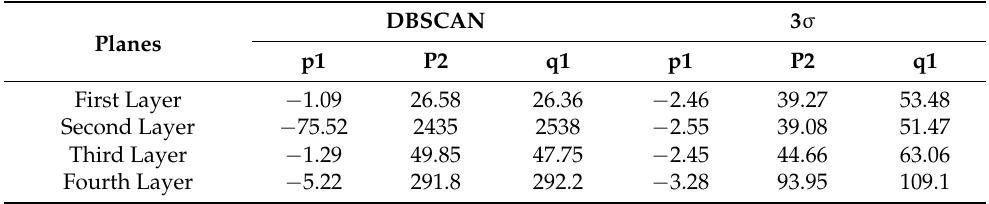
Table 4. Model parameters of grain temperature correlation coefficient threshold on the YOZ plane. Planes